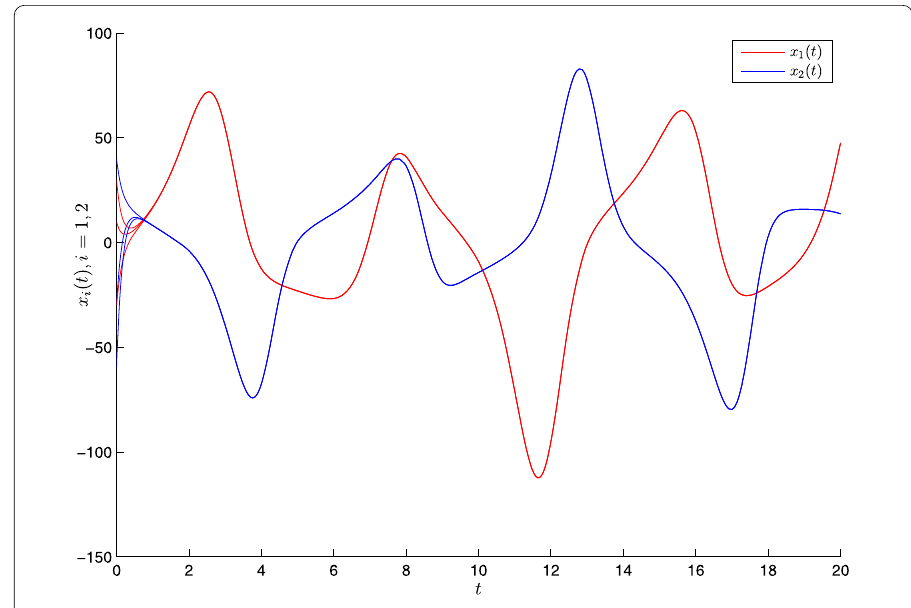
Figure 1 Numerical solutions of system (4.1) with different initial